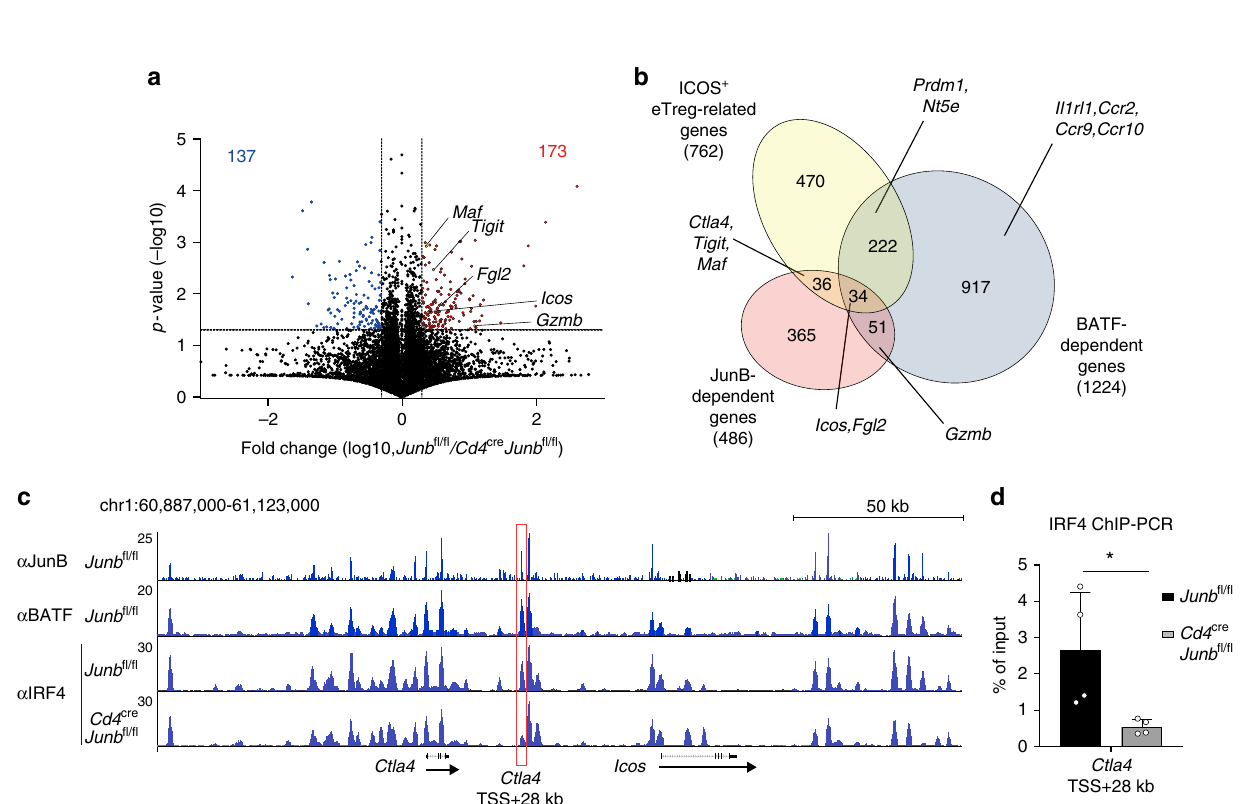
Fig. 6 JunB diversi fi es targets for BATF and IRF4 in eTreg cells. a – c RNA-seq analysis of CD4 + CD25 + Treg cells isolated from spleens of Cd4 Cre Junb fl / fl and Junb fl / fl mice. a Volcano plot comparing gene expression of Treg cells isolated from Cd4 Cre Junb fl / fl mice versus those from Junb fl / fl mice. b Venn diagram of genes upregulated by JunB (JunB-dependent genes) and BATF (BATF-dependent genes), and genes expressed in ICOS-expressing CD62L lo eTreg cells. c ChIP-seq analysis of CD4 + CD25 + Treg cells isolated from spleens of Cd4 Cre Junb fl / fl and Junb fl / fl mice. Cells were stimulated with anti-CD3 and anti-CD28 antibodies in the presence of IL-2 for 60 h and used for ChIP-Seq analysis with antibodies against JunB, BATF, and IRF4. The genomic region containing Ctla4 and Icos genes was shown. The red box indicates a region located 28 kb downstream of transcription start site of Ctla4 ( Ctla4 TSS + 28 kb) in which the level of IRF4-binding was signi fi cantly decreased by JunB de fi ciency. Arrows indicate the direction of gene transcription. d ChIP-PCR analysis of CD4 + CD25 + Treg cells isolated from spleens of Cd4 Cre Junb fl / fl and Junb fl / fl mice. Cells were stimulated with anti-CD3 and anti-CD28 antibodies in the presence of IL-2 for 72 h and used for ChIP with anti-IRF4 antibody. Immunoprecipitated DNA was analyzed by qPCR using primers to detect the IRF4- binding site located in the Ctla4 TSS + 28 kb region. Error bars indicate s.d. ( n = 4). * P < 0.05 (unpaired two-tailed Student ’ s t test). Data represent two